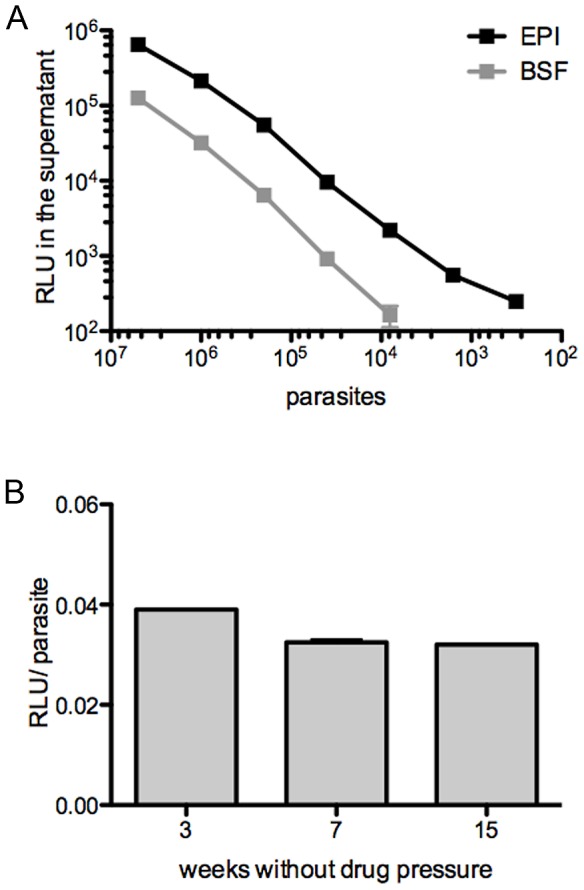
Characterization of bioluminescence production by epimastigotes and bloodstream evolutive forms of TvLrDNA-luc strain.
A. Serial dilutions of TvLrDNA-luc epimastigotes (EPI, black squares) or bloodstream forms purified from blood (BSF, gray squares) were measured in vitro for bioluminescent activity expressed in RLU (Relative Light Unit); the results are representative of more than three independent experiments. B. Bioluminescence emission per TvLrDNA-luc BSF without drug pressure selection; the results are expressed in RLU/parasite and correspond to arithmetic means +/− SD of the means; p>0,05.